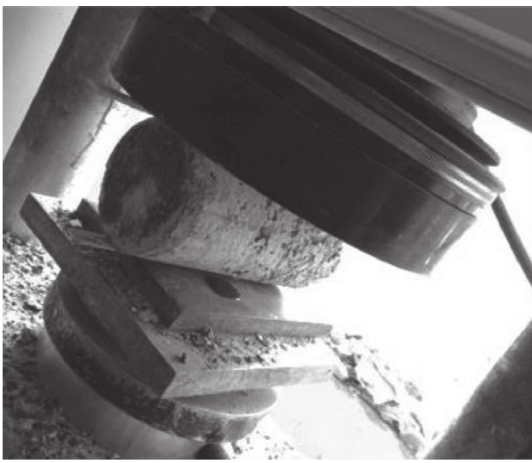
Figure 3: Specimen prepared for splitting tensile test.